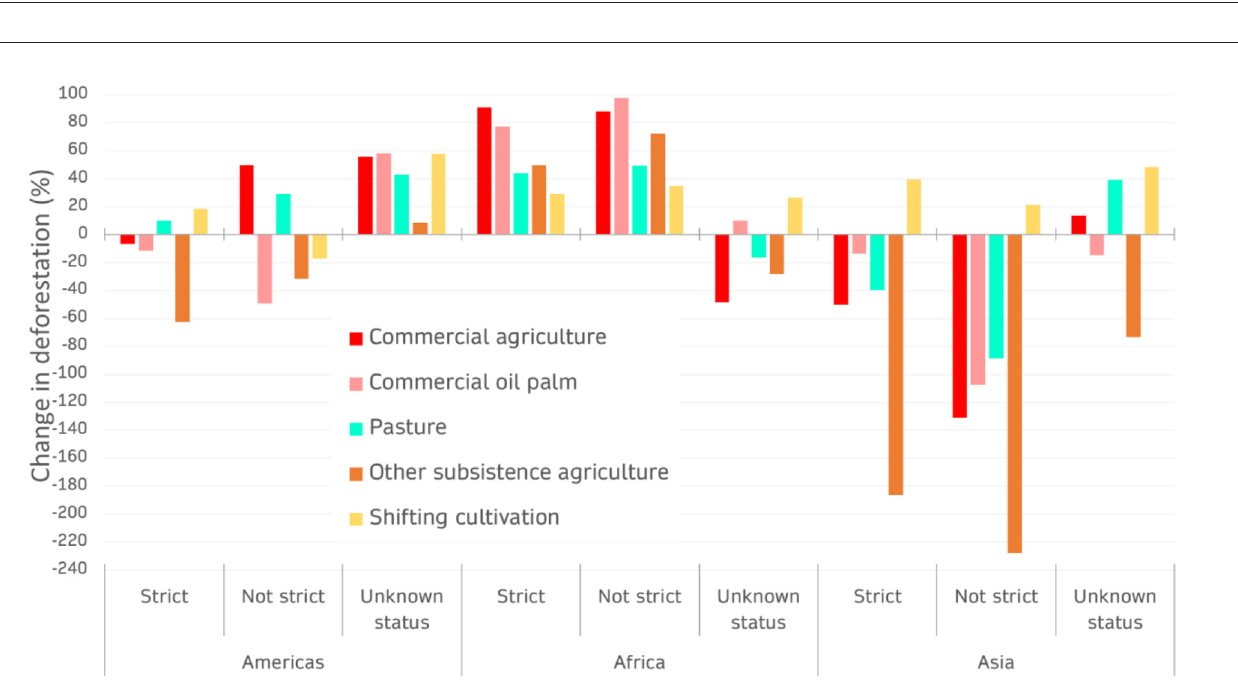
FIGURE 7 | Percentage reduction in deforestation in protected areas by driver and by degree of protection (grouped into strict, non-strict, and unknown) for the Americas, Africa, and Asia in the area 30 ◦ latitude north and south of the